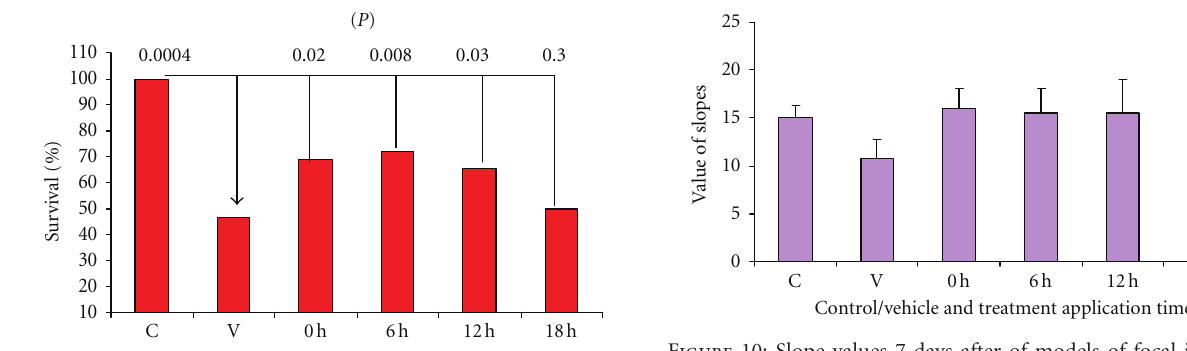
Figure 10: Slope values 7 days after of models of focal ischemia. P values of comparison against the vehicle group by the U test of Mann and Whitney. ( n = 35 per group). Dose Neuro-EPO IN 249.4